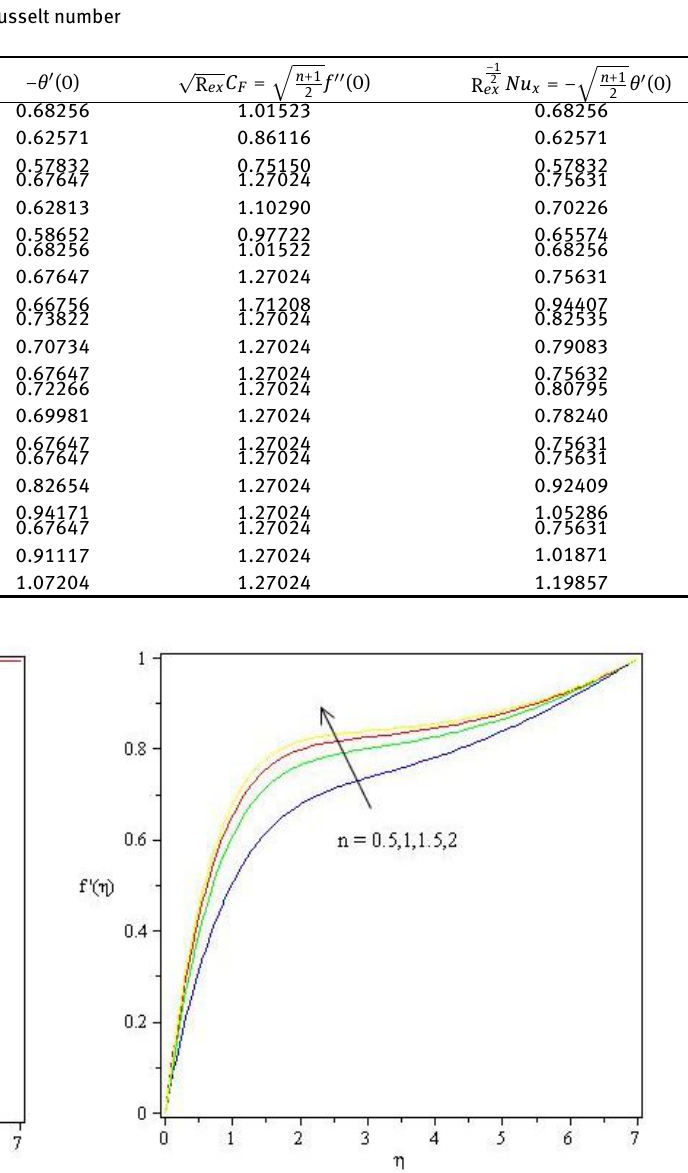
Fig. 5: Velocity profile for different values of n and different parame- ter p = 1, pr = 1, M = 0.5, A = −0.05, B =